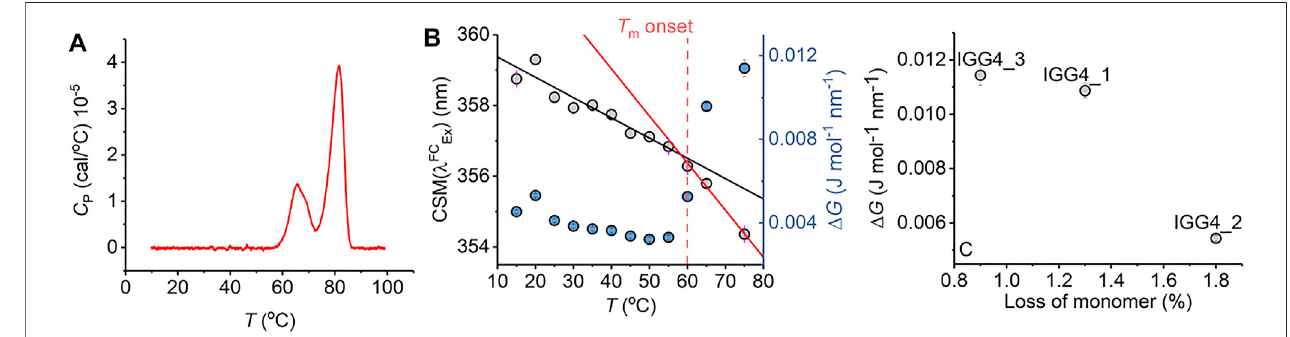
FIGURE 5 | Antibody stability prediction and the effect of temperature. (A) Differential scanning calorimetry data for mAb1. (B) Temperature dependence of parametersextractedfrom fi ttingtheIgG1REESdatato Eq.(7) . (C) PercentagelossofmonomerformAb1-3after6 monthsincubationatroomtemperature versus Δ G extracted from fi tting REEs data to Eq. (7) at t (cid:2) 0. Raw REES data from panel (C) as reported previously in Ref.